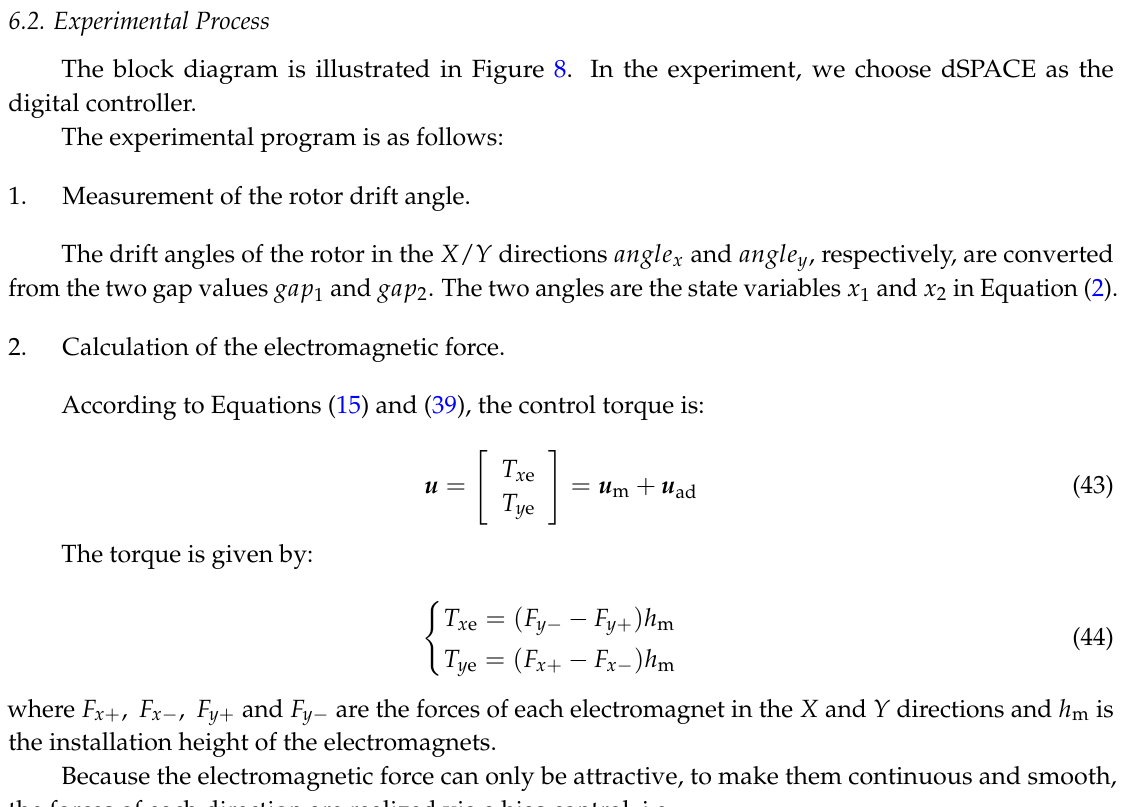
Figure 7. Experimental platform for the orientation control system: ( a ) electromagnet; ( b ) rotor; ( c ) universal joint; ( d )